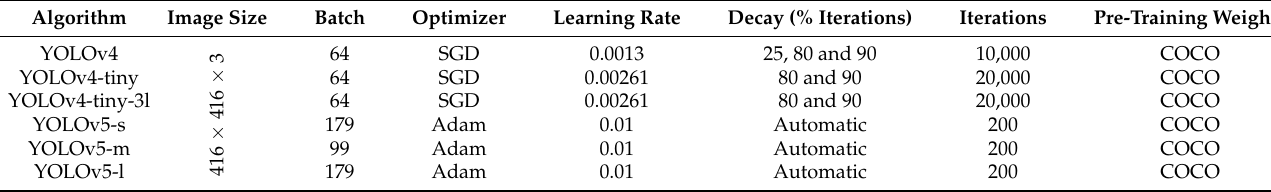
Table 5. Algorithm training